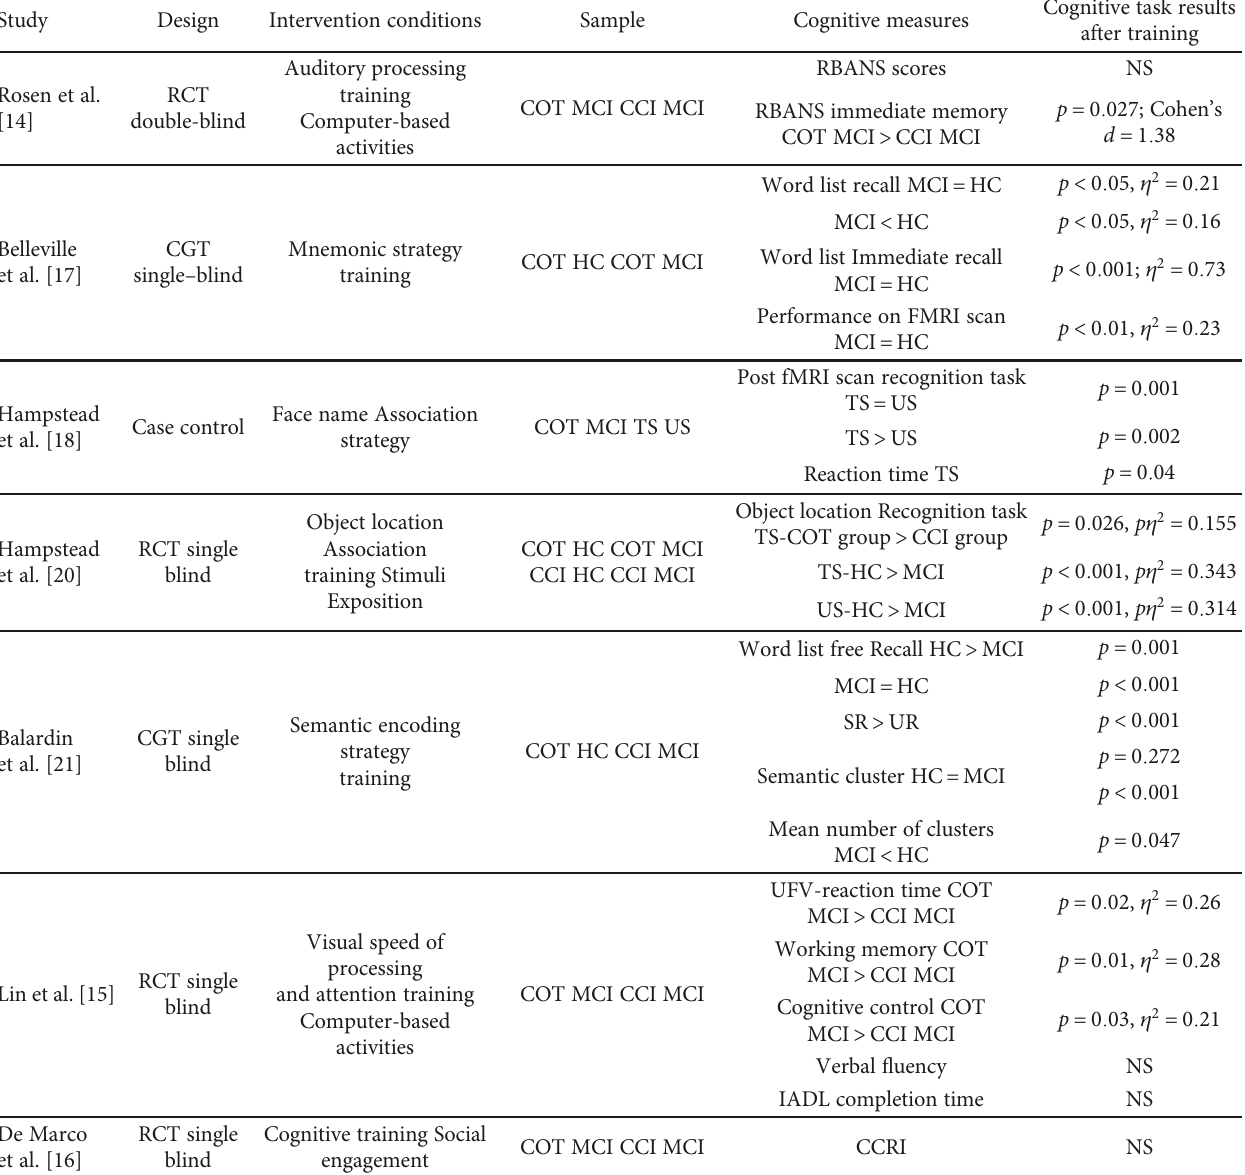
Table 2: COT e ff ects on neuropsychological